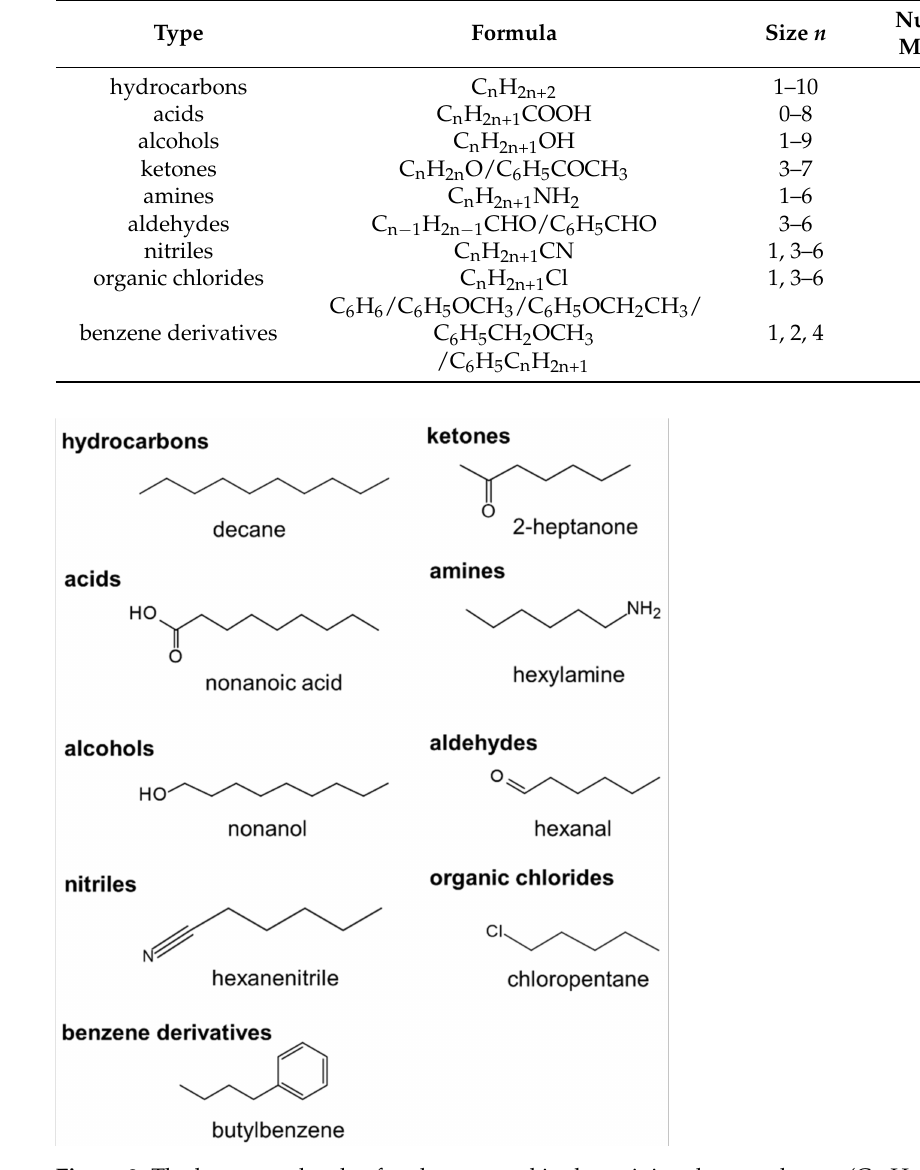
Figure 2. The largest molecule of each type used in the training dataset: decane (C 10 H 22 ), nonanoic acid (C 8 H 17 COOH), nonanol (C 9 H 19 OH), 2-heptanone (C 7 H 14 O), hexylamine (C 6 H 13 NH 2 ), hexanal (C 5 H 11 CHO), hexanenitrile (C 5 H 11 CN), chloropentane (C 5 H 11 Cl) and butylbenzene (C 6 H 5 C 4 H 9 ). The organic molecules in both datasets cover a wide range of ∆ H vap values, from 8.19 kJ/mol (methane) to 69.00 kJ/mol (heptanoic acid), and represent different chemical structures. The experimental values of ∆ H vap for all molecules, measured around a normal boiling point, were collected from the literature (see Supplementary